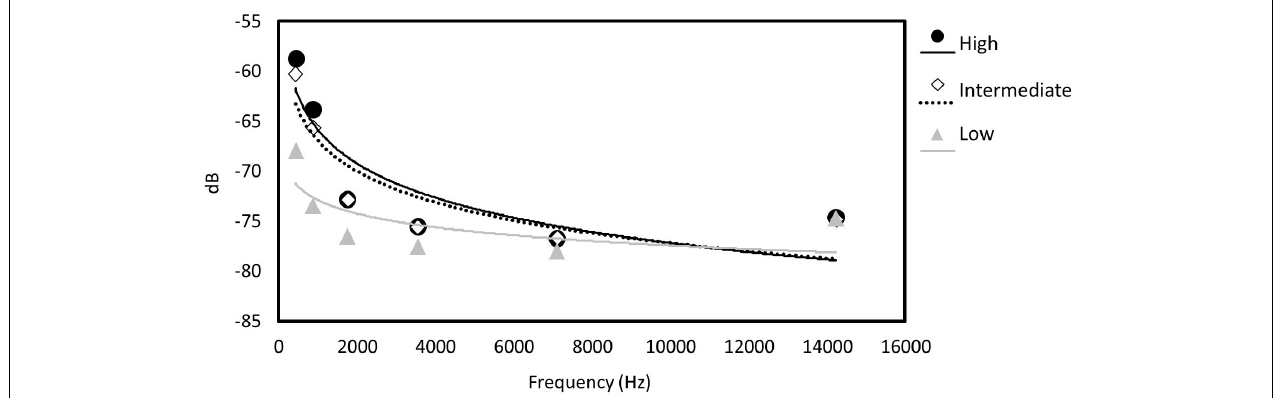
FIGURE 3 | Relative measurements of sound amplitude measured from recordings for the six frequency octave bands per site using Raven Pro software. Sites are represented by symbols and fitted lines. High industrial disturbances, black dots and line; moderate footprint, hollow diamonds and dotted line; low disturbances, gray triangles and line.